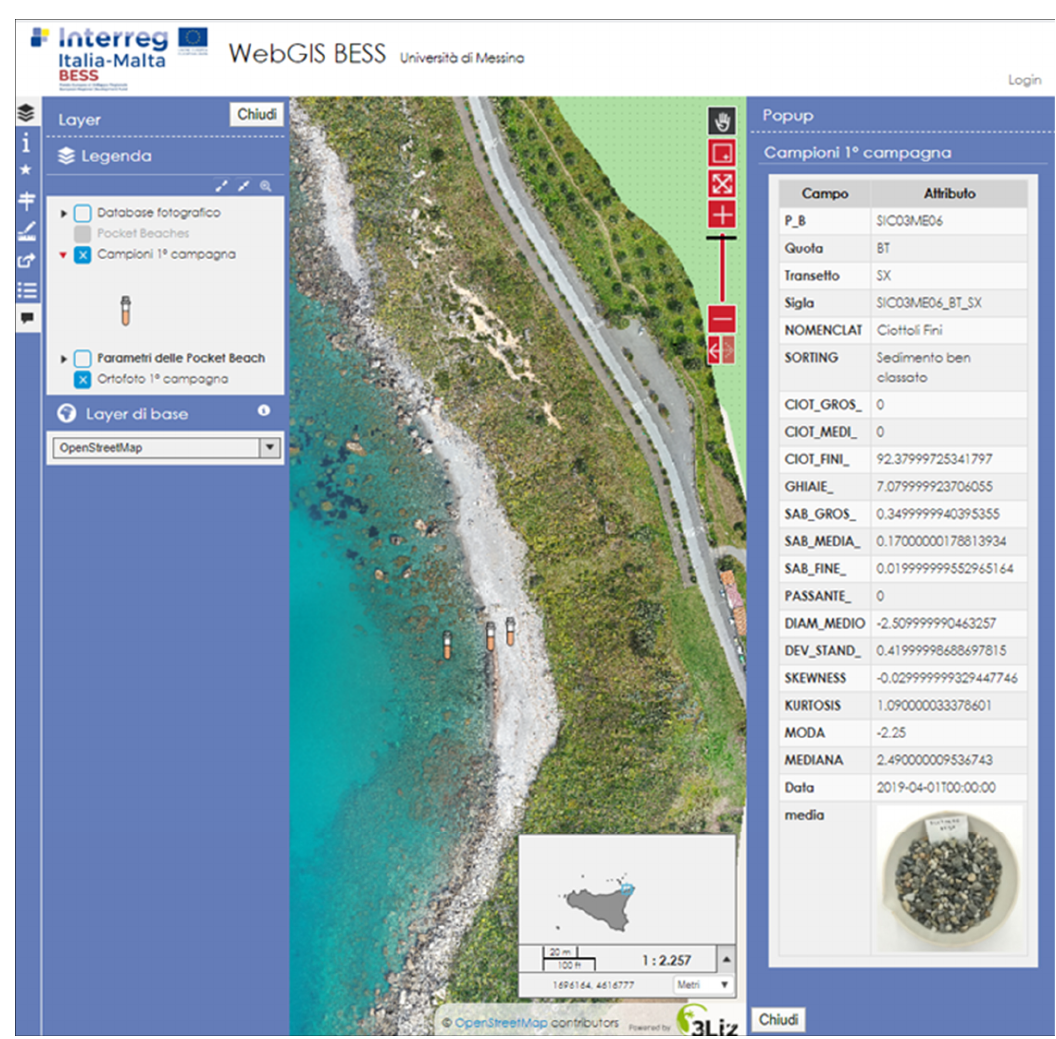
Figure 5. Display of the platform with the opening of a popup relative to the grain size information about the shoreline sample of Capo Milazzo’s PB.